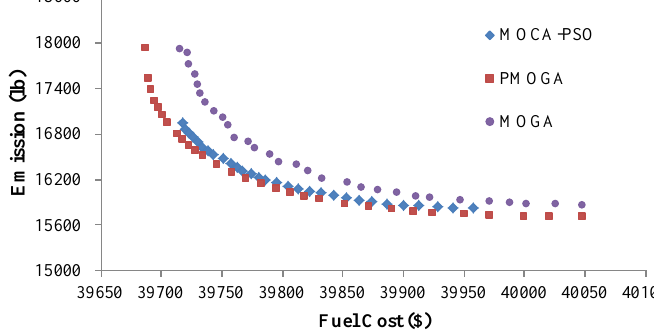
Figure 7. The optimal Pareto front by different algorithms for Case 1. Table 1. The non-dominated schemes obtained by different methods for Case 1.